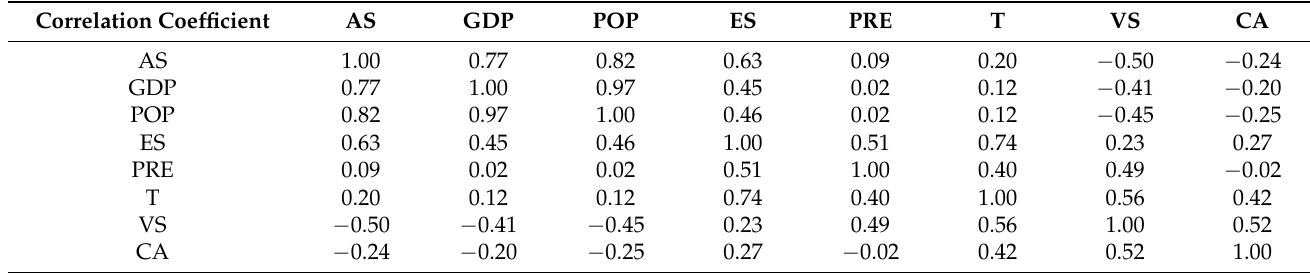
Table 6. Correlation coefficients of influencing factors.